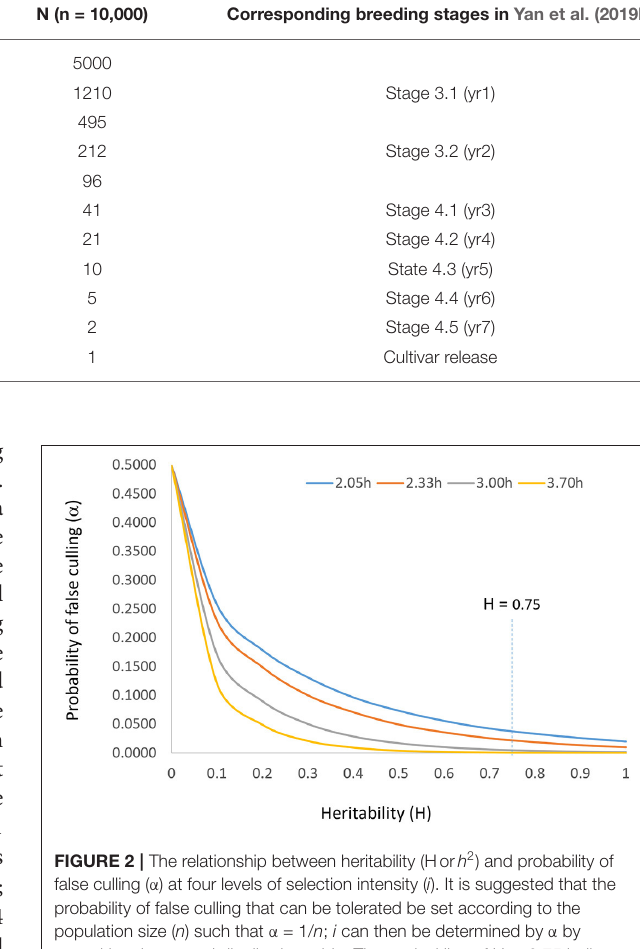
Chaudhary (1977) suggested setting i with this